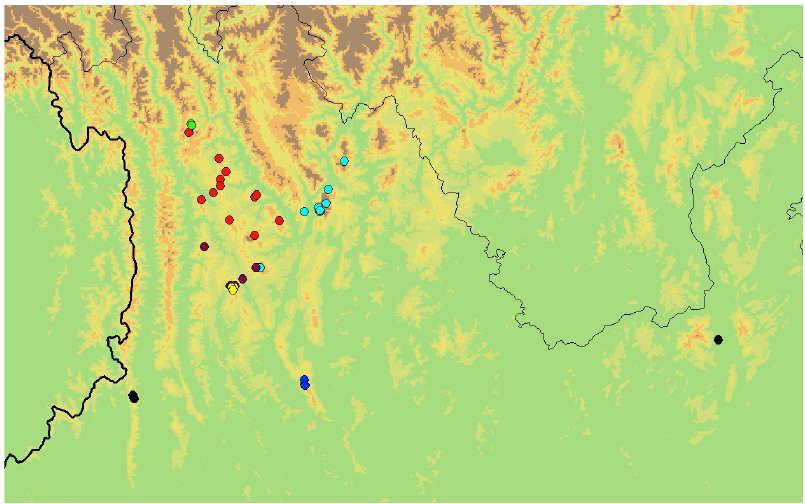
Figure 9. Distribution of the species of the subgenus Chrysolina ( Volosatik ): (green) Ch. igori sp. nov.; (red) Ch. fascinatrix ; (light blue) Ch. liqingzhaoae ; (purple) Ch. marinae sp. nov.; (yellow) Ch. genriki sp. nov.; (black) Ch. wangi ; (dark blue) Ch. ilyakabaki sp. nov. Chrysolina fascinatrix Lopatin, 1998: 831. Type locality. China, NW Yunnan, 20 km E Weixi.